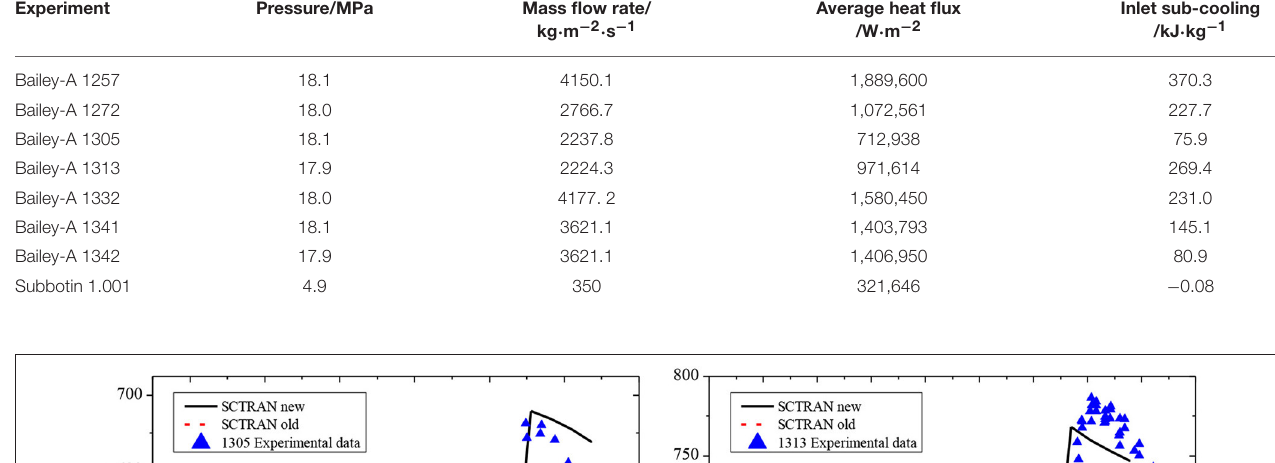
TABLE 4 | Experimental conditions.